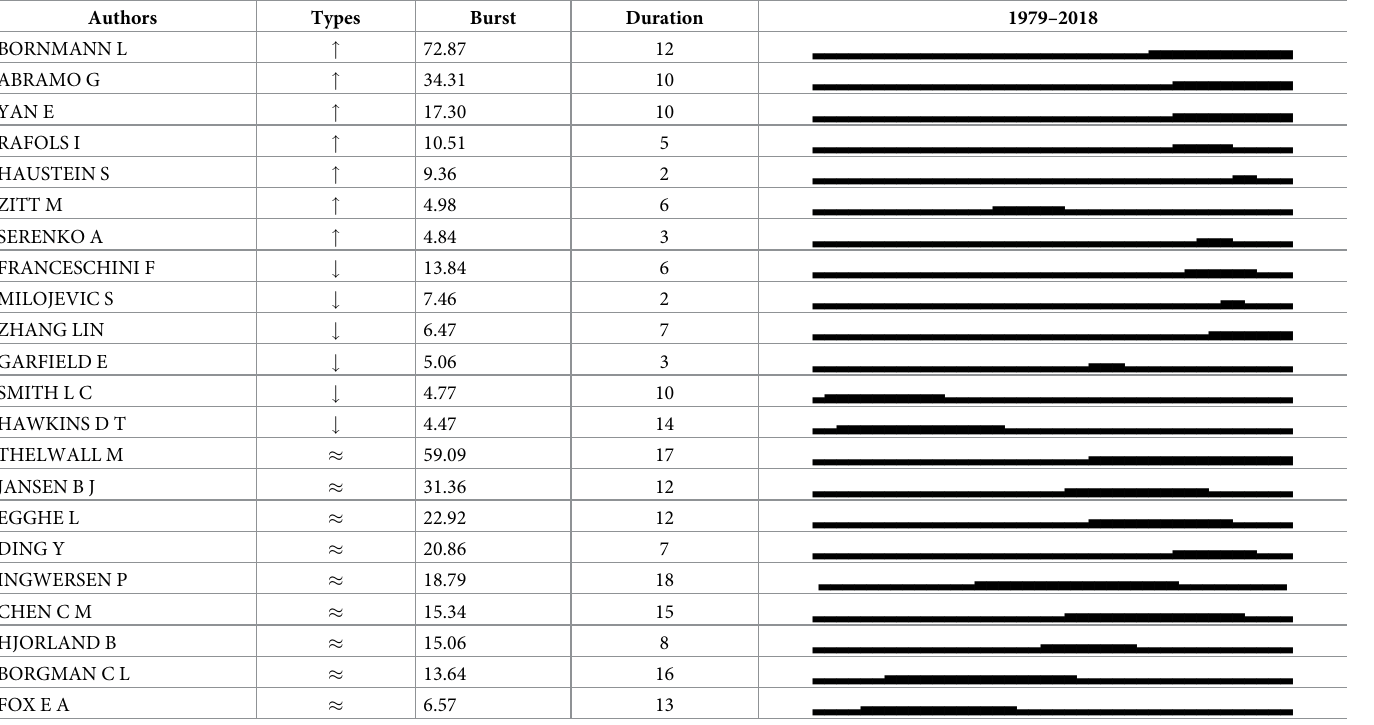
Table 5. Researchers burst four types of